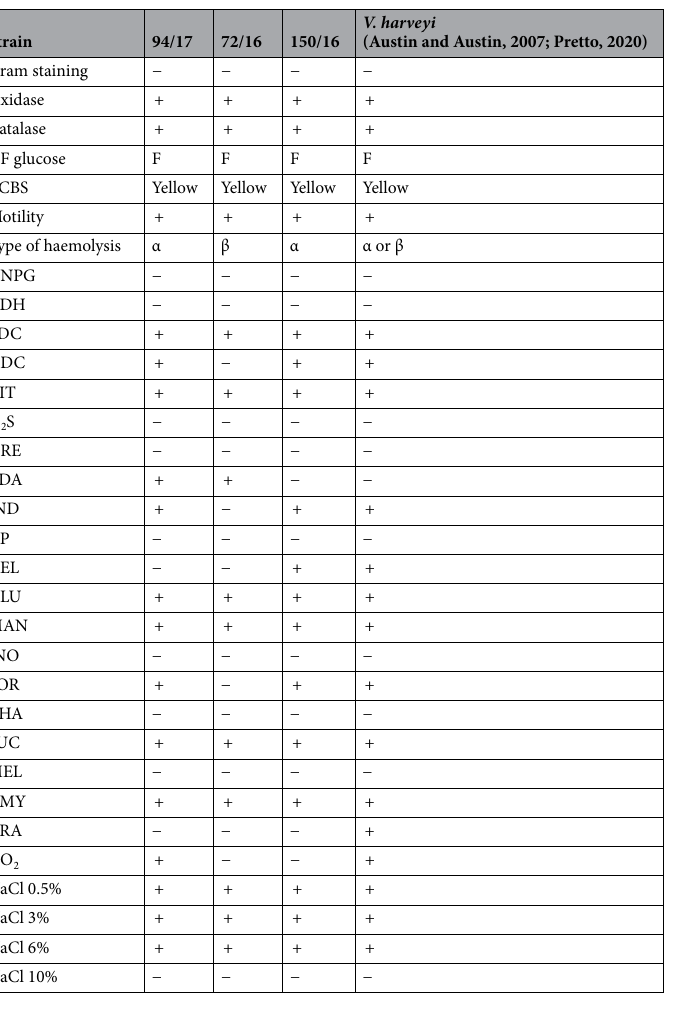
Table 1. Biochemical and physiological properties of V . harveyi strains. OF = glucose oxidation-fermentation test, F = fermentative, ONPG = β-galactosidase, ADH = arginine dihydrolase, LDC = lysine decarboxylase, MAN = mannitol, INO = inositol, SOR = sorbitol, RHA = rhamnose, SUC = sucrose, MEL = melibiose, AMY = amygdalin, ARA = arabinose, NO 2 = reduction of nitrates to